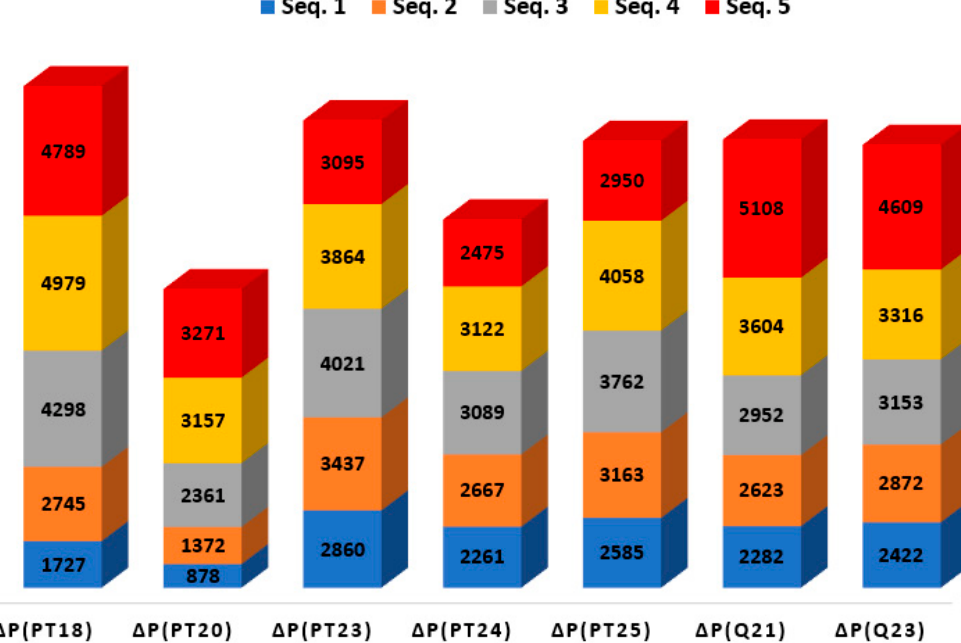
Figure 10. Influence of thickness on annual heating demand for building A (W·h/m²).